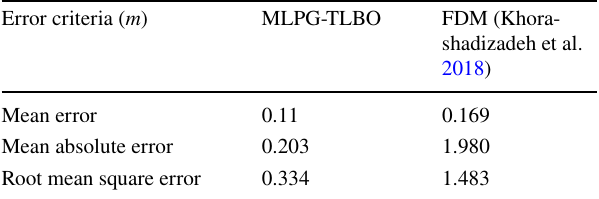
Table 5 Computation of error indices in unsteady state for both MLPG-TLBO and